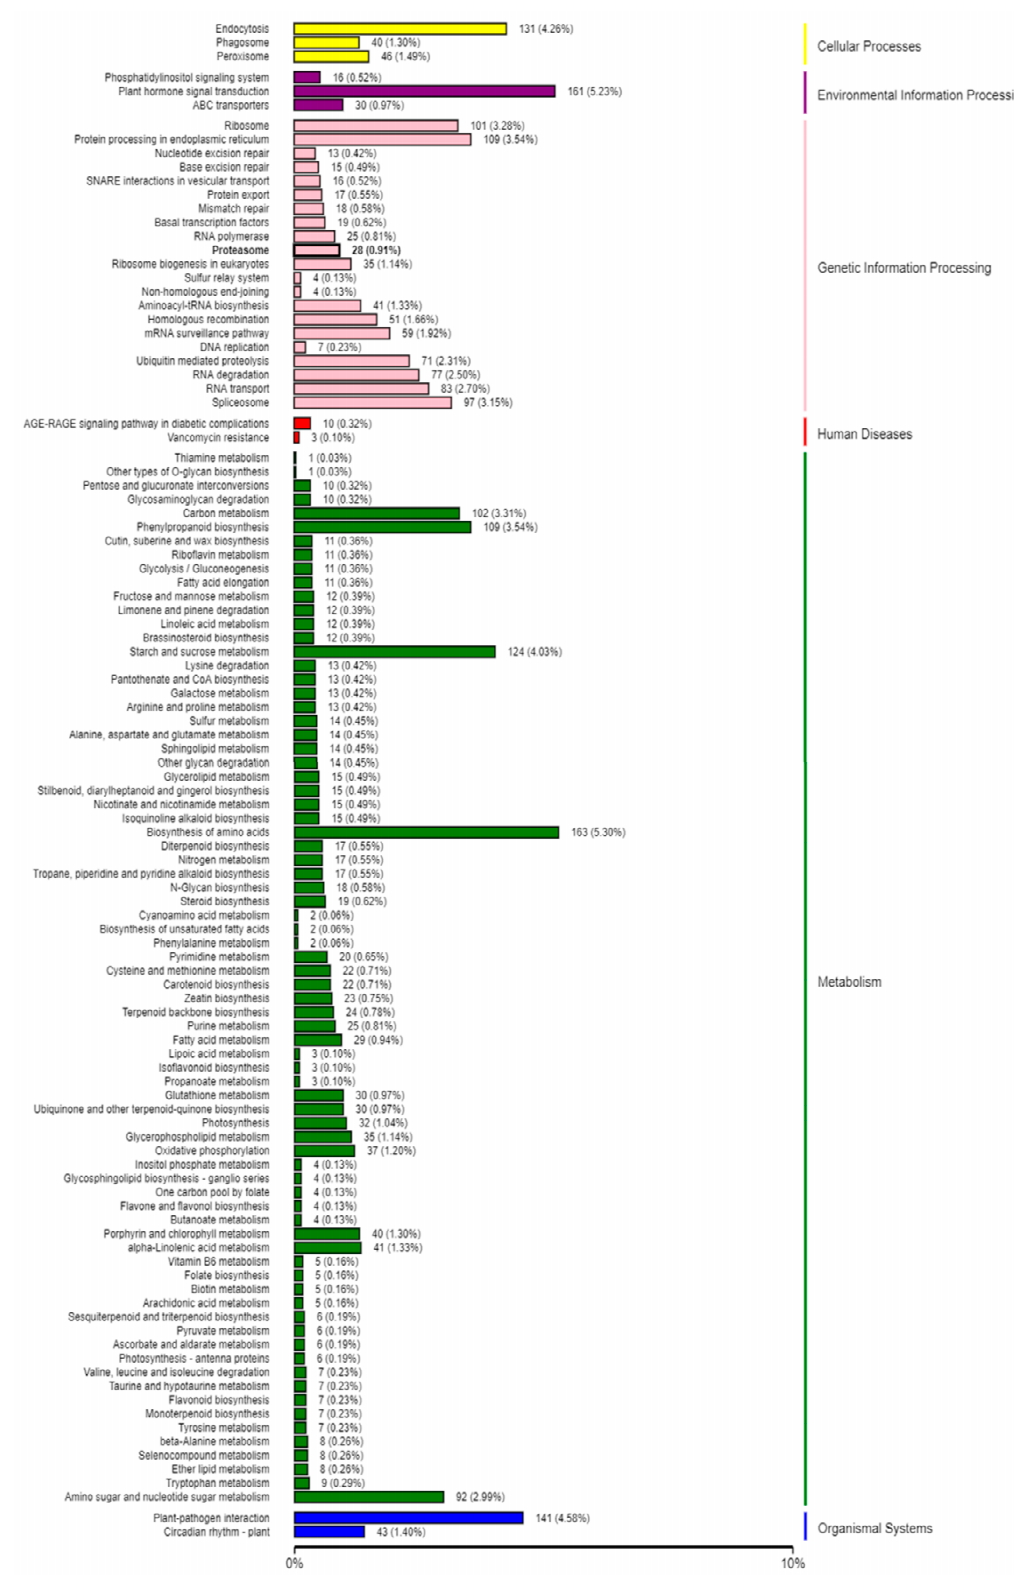
Figure 8. KEGG pathway classification of target genes of differentially expressed miRNAs. The left Y axis is the name of the KEGG metabolic pathway, the right Y axis is the biological process that these genes participated, and the X axis is the number and the percentage of target genes.